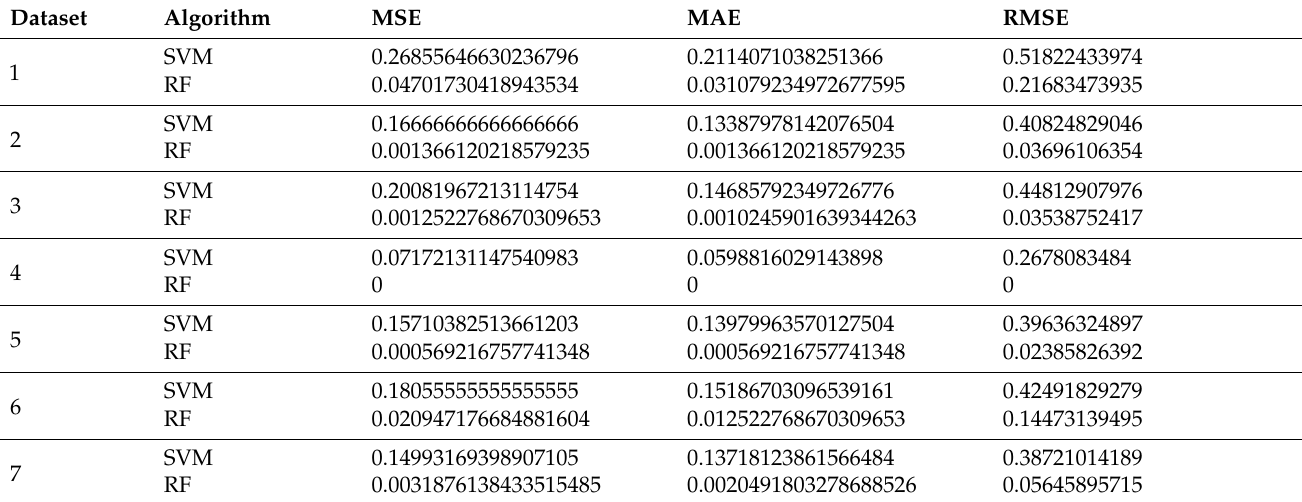
Table 7. Comparison of the RF model with the SVM